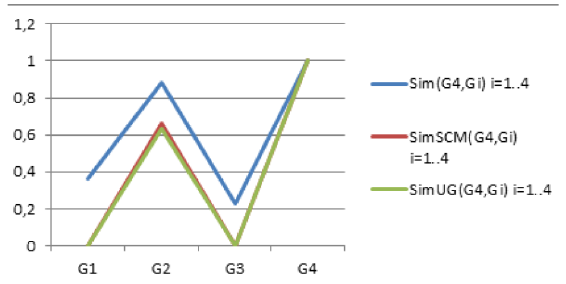
Fig. 4. * Comparison of our similarity, Sim UG and Sim